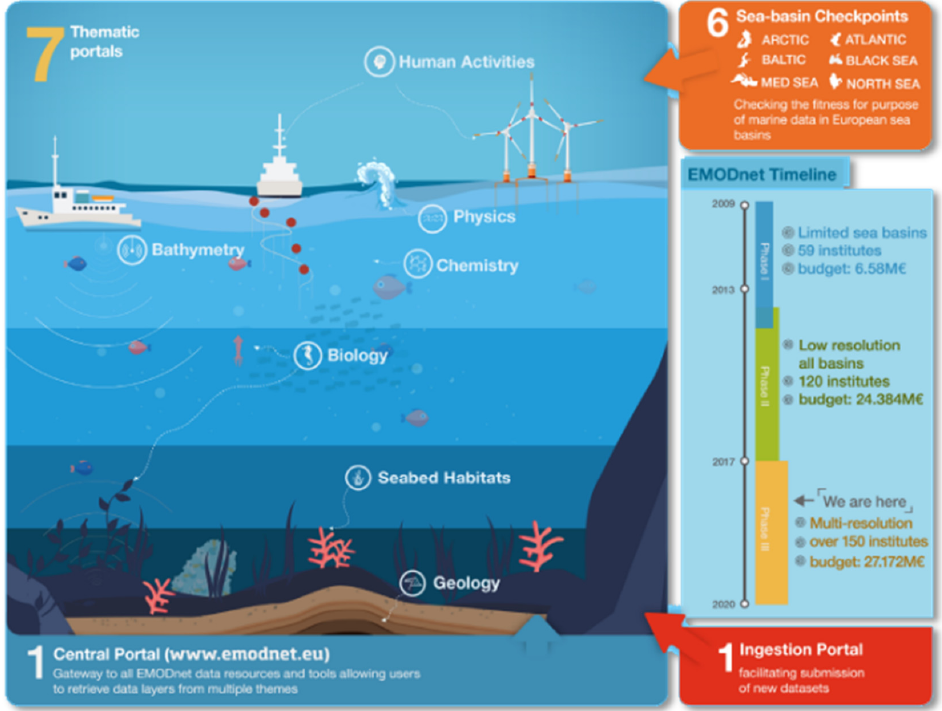
Figure 5. EMODnet infographic. Reproduced from https://emodnet.eu/sites/emodnet.eu/files/public/image_news/EMODnet_in_a_Nutshell.JPG (accessed on 8 May 2022).